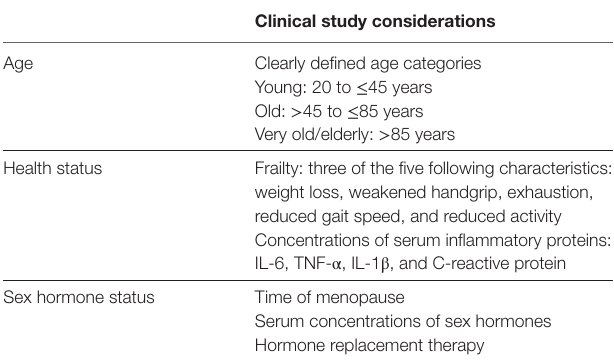
TABLe 3 | Variables to consider when designing clinical studies related to immunity in the aged. Clinical study